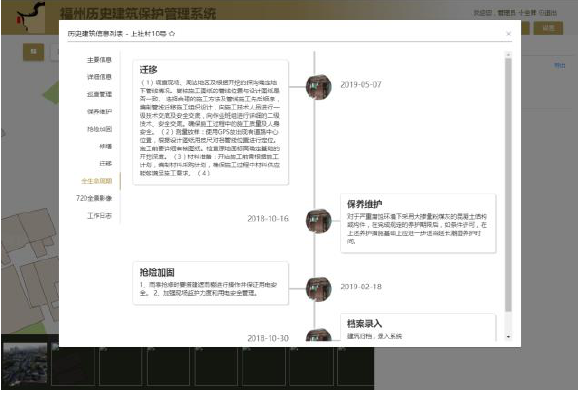
Figure 5. Full Life Cycle Management of Historical Buildings